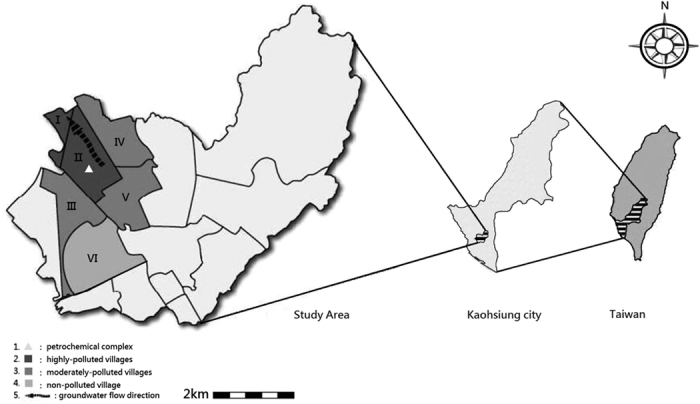
The study area and the direction of groundwater flow.The source map was generated from OpenStreetMap online platform (http://openstreetmap.tw/osmtw) (©OpenStreetMap) and modified by Microsoft Paint version 5.1 with illustrator CC(2014). The cartography in the OpenStreetMap map tiles is licensed under CC BY-SA (http://www.openstreetmap.org/copyright). The licence terms can be found on the following link: http://creativecommons.org/licenses/by-sa/2.0/. Microsoft Paint version 5.1 → base map creation URL: http://en.softonic.com/s/microsoft-paint-version-5.1/windows-xp illustrator CC(2014) → base map modification URL:http://getintopc.com/softwares/graphic-design/adobe-illustrator-cc-2014-free-download/.